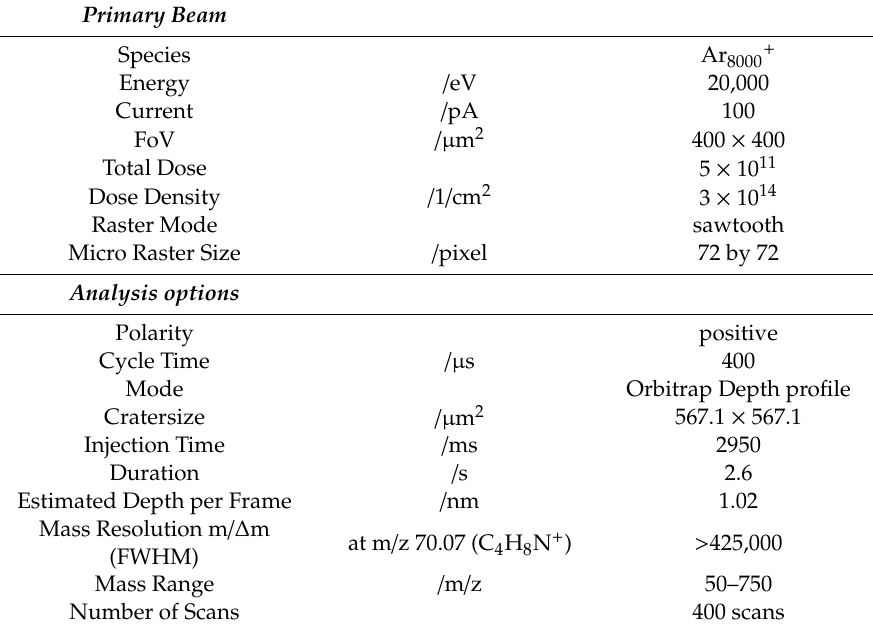
Table 3. Parameters for measurements with IONTOF’s M6 Hybrid